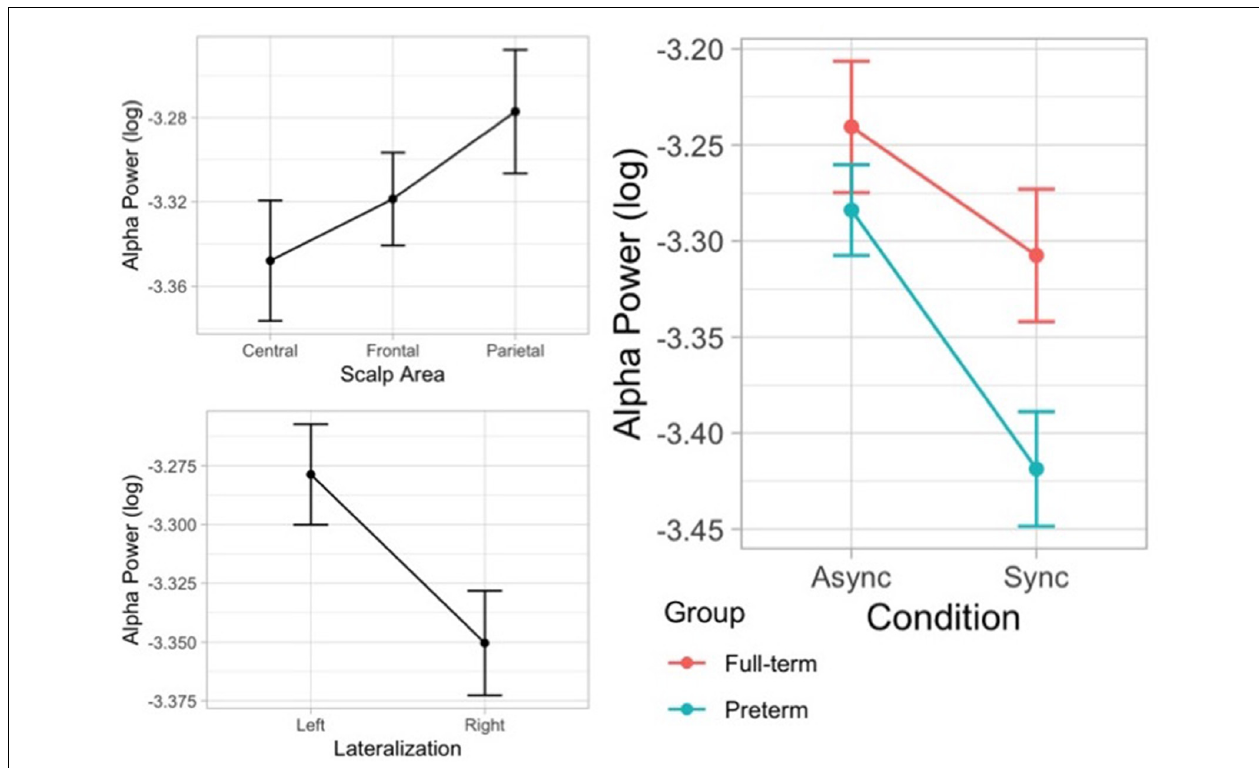
FIGURE 8 | Error bar graphs of the mean alpha power showing the main effects of scalp area, lateralization, and the interaction effect between visual-tactile condition (asynchronous vs. synchronous) and group (full-term vs.